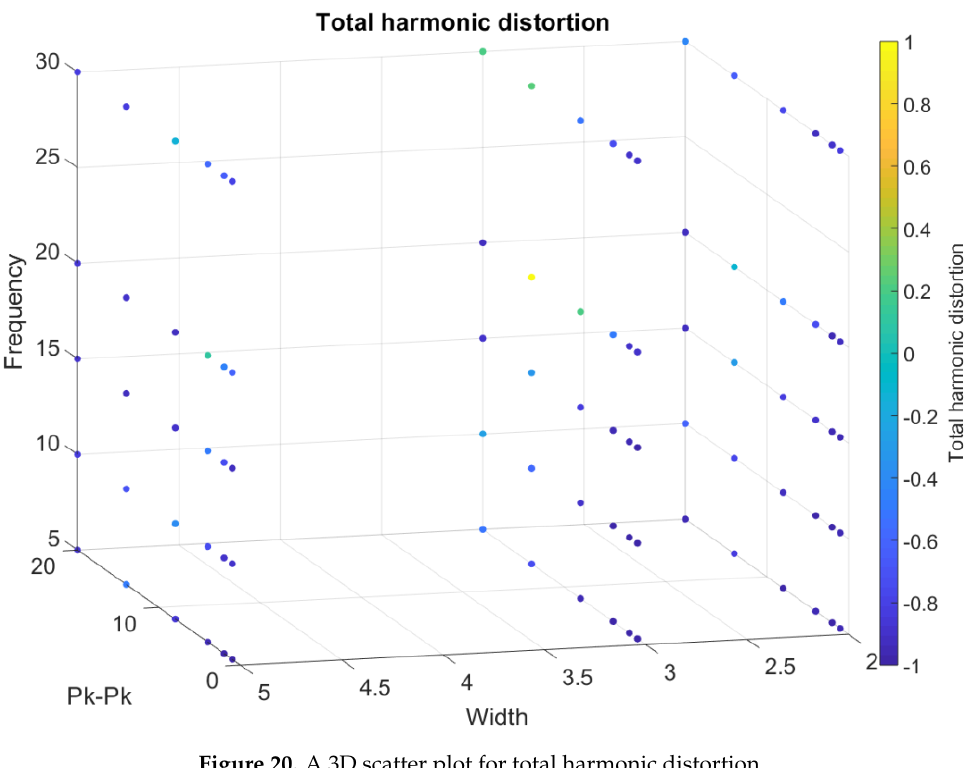
Figure 20. A 3D scatter plot for total harmonic distortion.